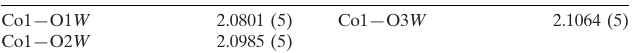
Selected bond lengths (A˚ ).